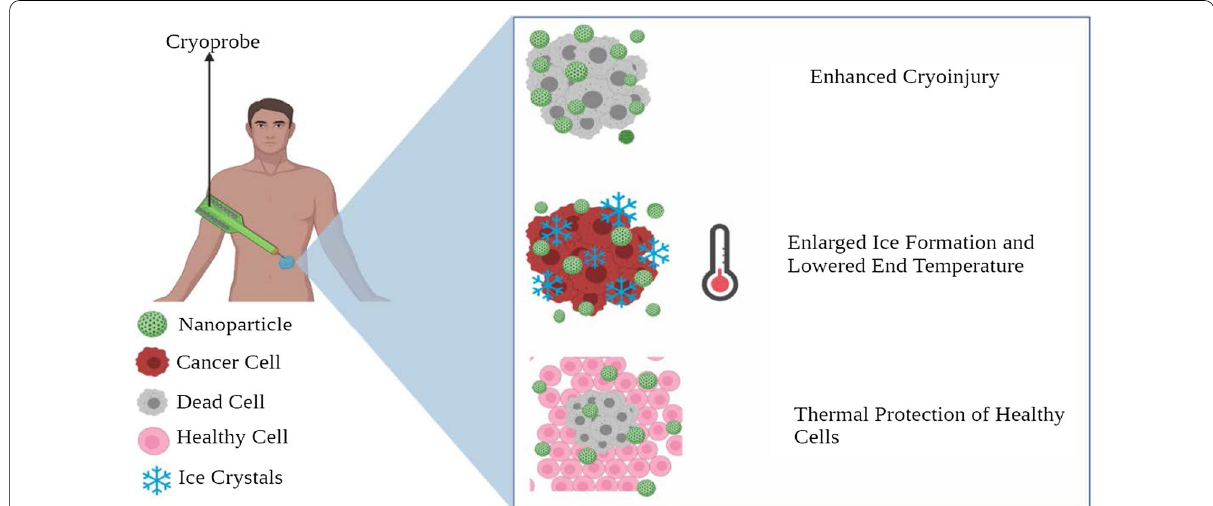
Fig. 6 Diagrammatic representation of NPs in